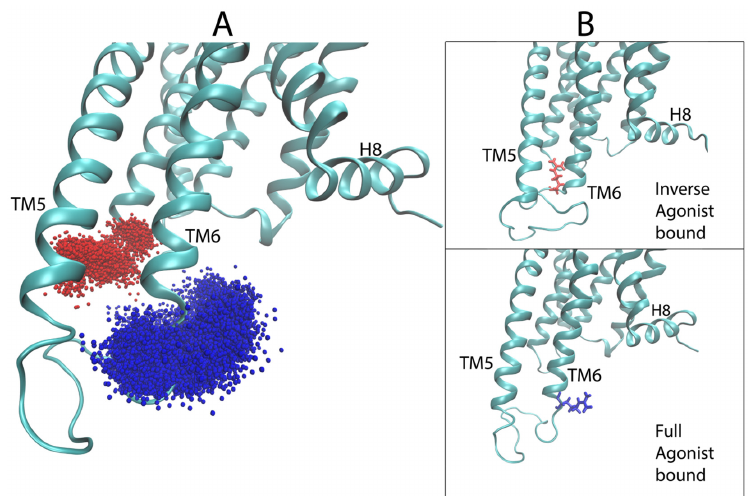
Figure 9. Conformational dynamics of residue R310 in ICL3 identified by the epsilon hydrogen highlighted by the sensitivity analysis. ( A ) Sampling of the coordinate of the epsilon hydrogen of R310 (atom 3535) in the ICL3, over all of the aligned trajectories of the 5-HT2AR bound to the inverse agonist ketanserin (red) and the full agonist serotonin (blue). ( B ) Example frames from each class of trajectories shown in panel A. R310 is colored solidly according to the bound ligand, KET (red) and 5-HT (blue). The conformations of the partial agonist trajectories are discriminated by a different set of residues. The ICL3 of the partial agonist is not differentiated by the R310 H ε , because in the partial ICL3 in the partial agonist trajectories is different from the other complexes in that it preserves throughout the helical structure of the residue segment 306 to 310 of TM6, whereas the same piece of ICL3 samples a disordered/unfolded conformation in both the full and inverse agonist-bound trajectories (shown in Figure 9). This is evidenced by the sampling of T307 in the ICL3, a residue identified as important in the attention map of the partial agonist, but not the full agonist.